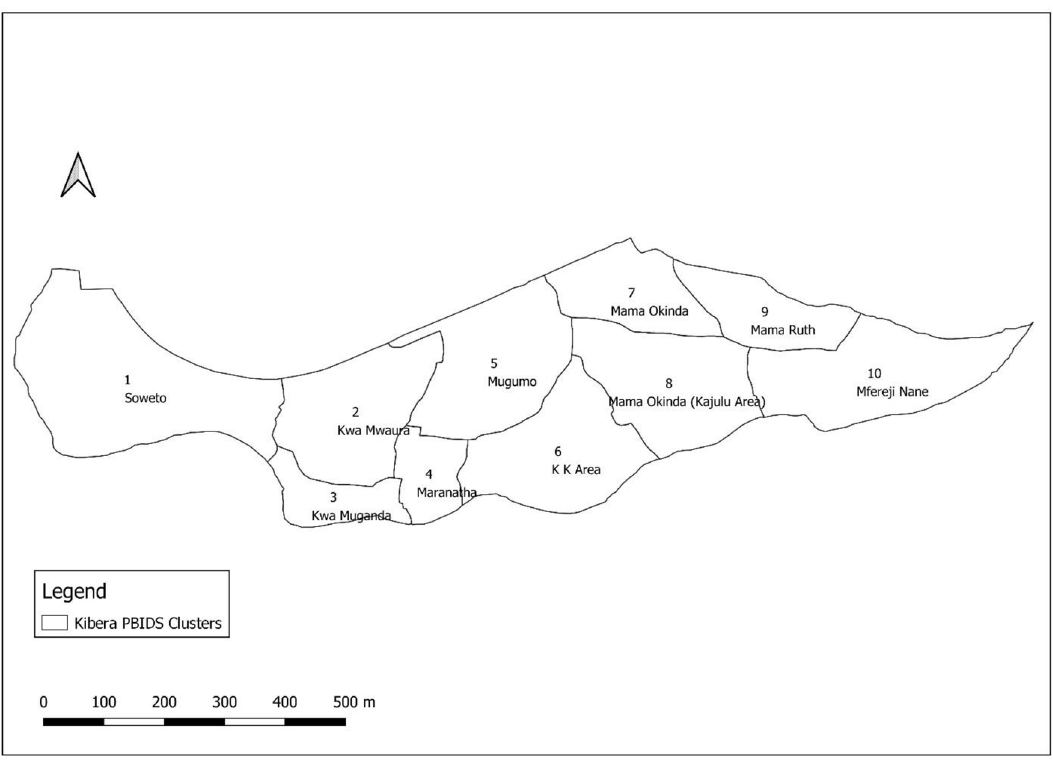
Figure 1. Map showing the area under population-based infectious disease surveillance (PBIDS) in Kibera informal settlement, Nairobi, Kenya. The subdivisions show the areas of residence i.e. PBIDS zones